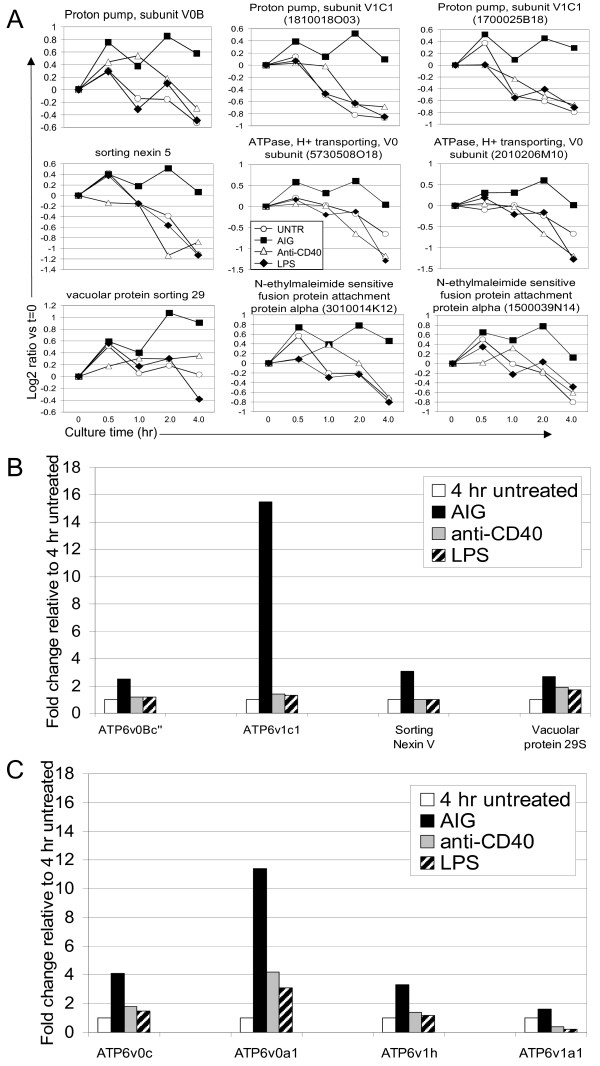
Expression data from select intracellular transport-related genes. (A) Microarray results for expression patterns of several genes over a timecourse of 0.5 to 4 hr. The log2(Cy5/Cy3) values were compared to 0 hr untreated samples (t = 0). Three examples of genes represented by two different probes (probe Ids in parentheses) are shown in the two right columns. (B) Real-time RT-PCR analysis of four intracellular transport-related genes at 4 hours of stimulation that were included in the microarray data set. Data were normalized to mouse 18S rRNA as a reference and compared to untreated samples. ATP6v0bc" and ATP6v1c1, n = 2. Sorting nexin V and Vacuolar protein 29S, n = 1. (C) Real-time RT-PCR analysis of 4 intracellular transport-related genes at 4 hours of stimulation that were not included in the microarray data set.